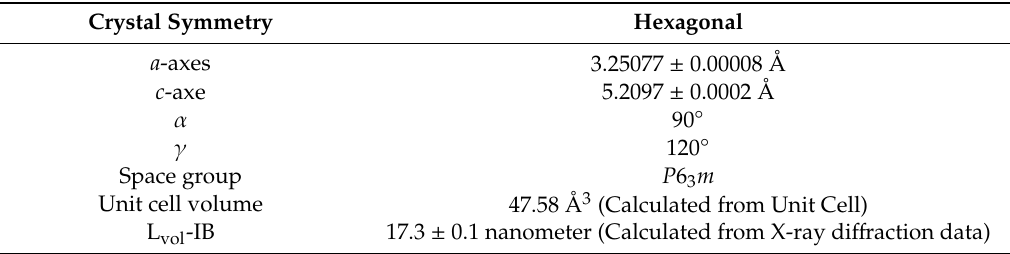
Figure 4. ( a ) Scanning electron microscopy (SEM) shows zinc oxide nanoparticles forms (ZnO NPs) foliarly applied to foxtail millet. Inset: The electron dispersive analysis (EDAX) profile where Zn and O are detected as the major elements. ( b ) X-ray di ff raction analysis verified that the zinc oxide nanoparticles have wurtzite-structural symmetry. Table 3. X-ray di ff raction analysis of ZnO NPs with calculated unit cell